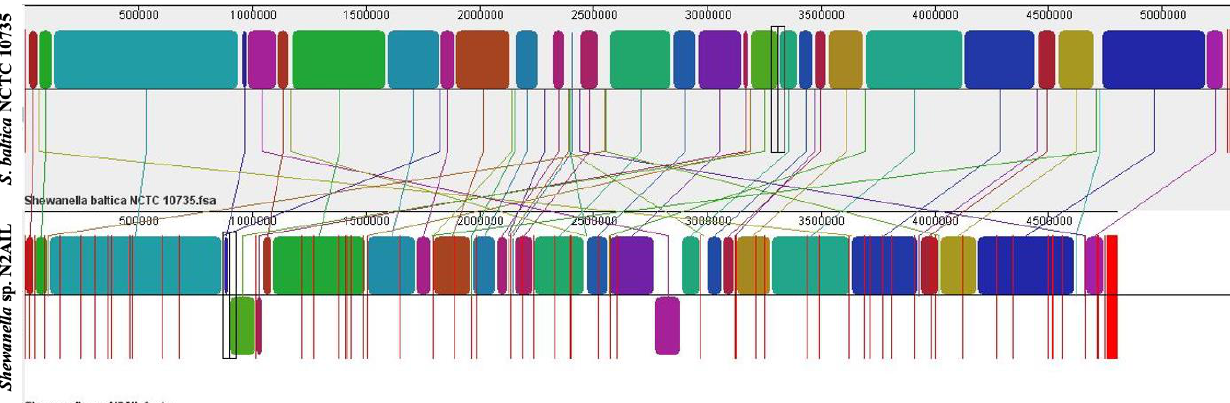
Figure 4. Venn diagram showing the distribution of shared and unique gene clusters of Shewanella sp. N2AIL with the related taxa ( a ), and comparison of the genes with the most closely related strain S . baltica NCTC 10735 ( b ).